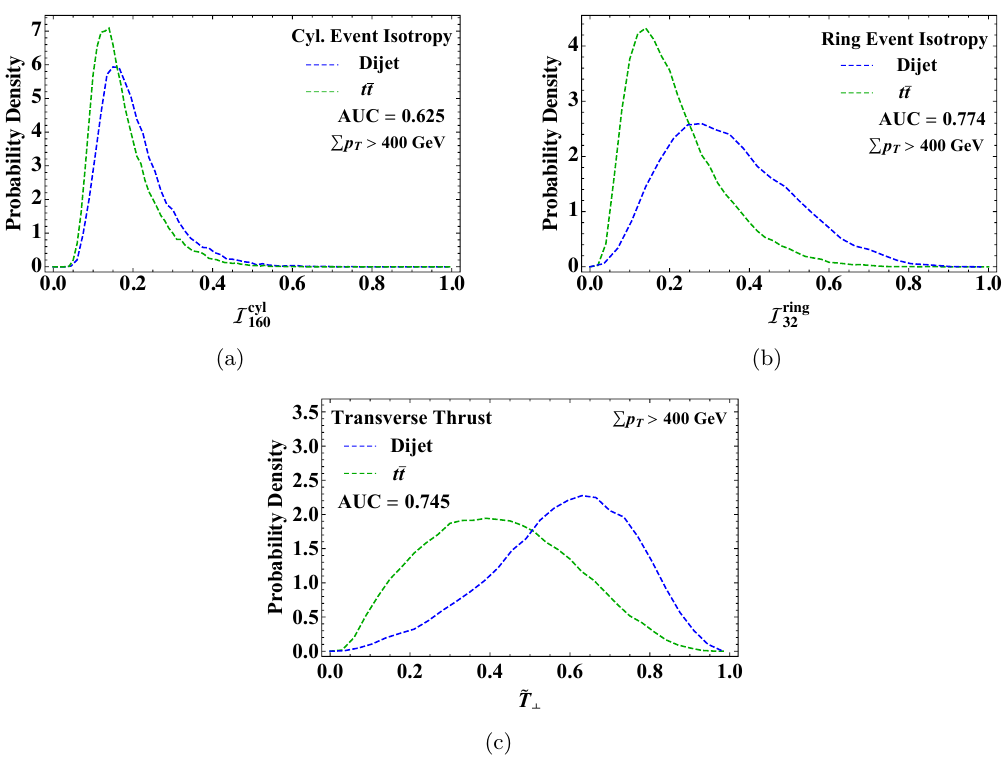
Figure 14 . The distributions of (a) cylindrical event isotropy, (b) ring-like event isotropy, and (c) transverse thrust in the QCD dijet and t (cid:22) t samples produced in pp collisions at